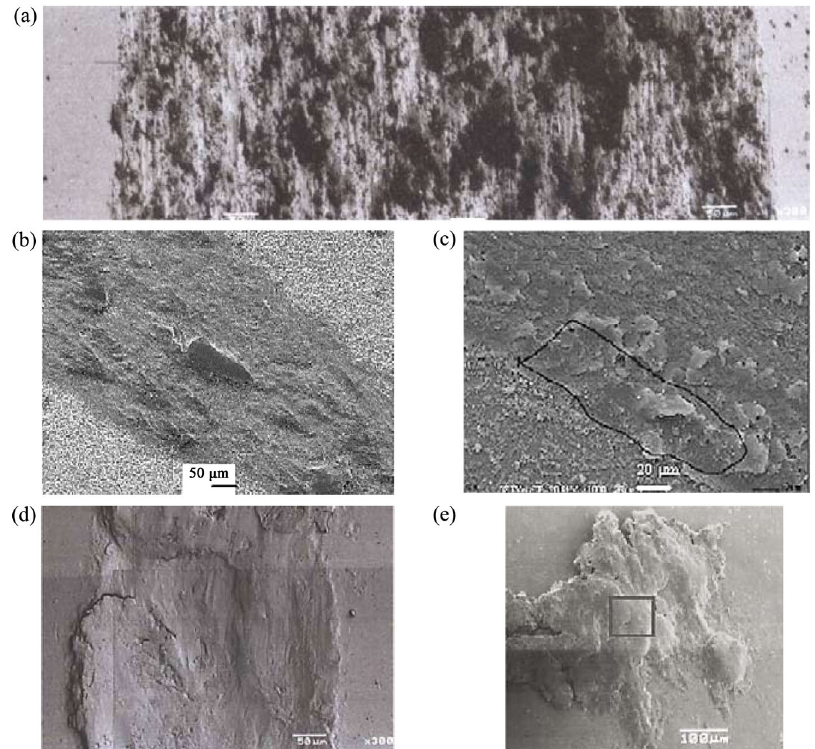
Fig. 8 SEM micrographs of worn-pin Ti64 surfaces and the counter-face tested at distinct conditions: (a) untreated (tested in ambient air); (b) ThO-Ti64 (tested in ambient air); (c) ThO-Ti64 (tested in vacuum); (d) untreated Ti64 (tested in vacuum); (e) steel counter-face with transfer material (tested in vacuum against untreated Ti64). Reproduced with permission from Ref. [94]. Copyright Elsevier,